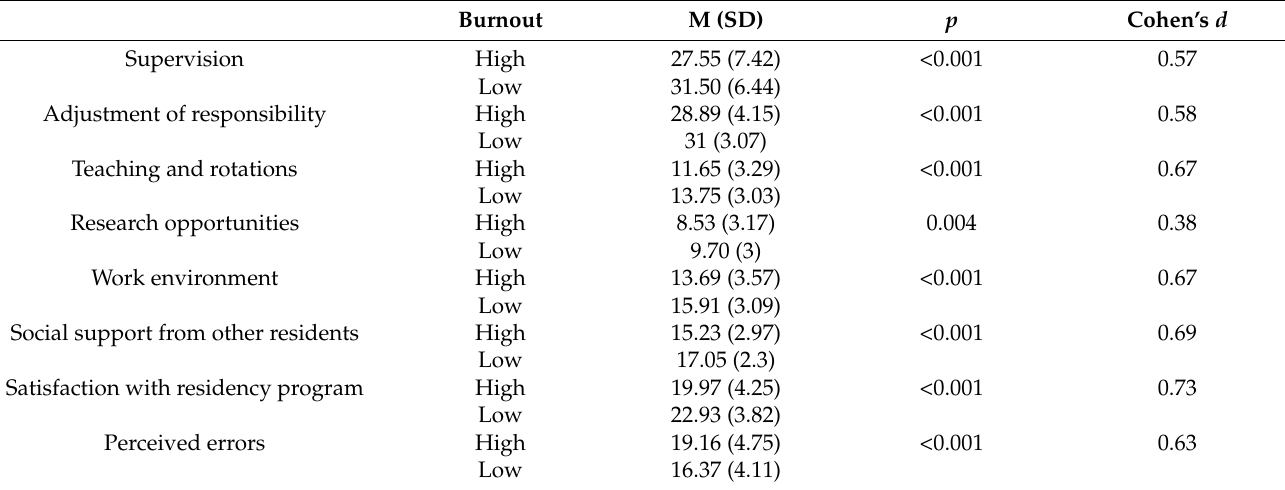
Table 4. Differences in work-related factors and errors according to the level of burnout.